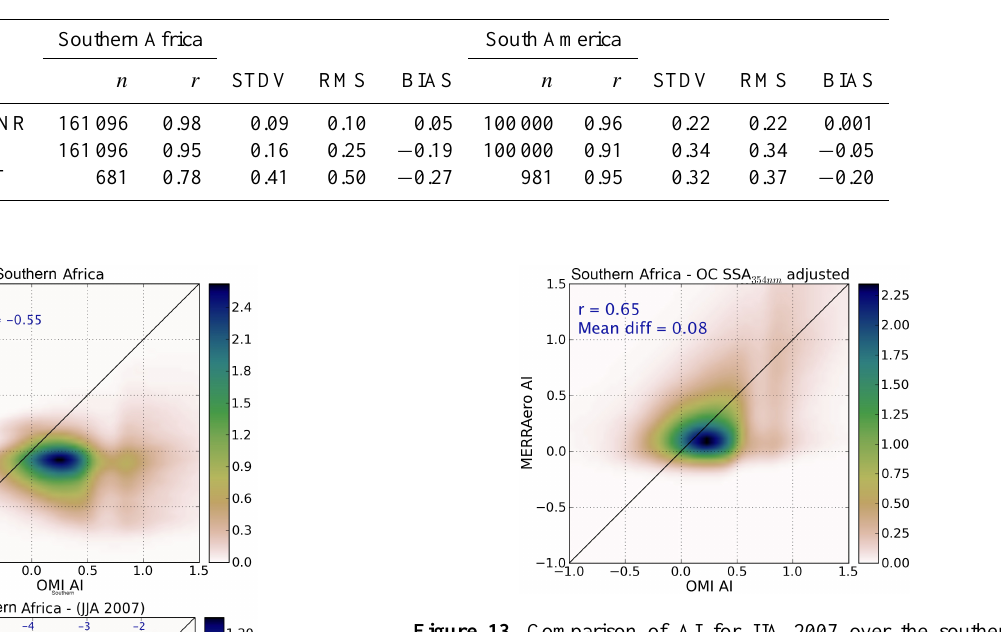
Table 3. Same as Table 1 but for the southern African and South American regions.